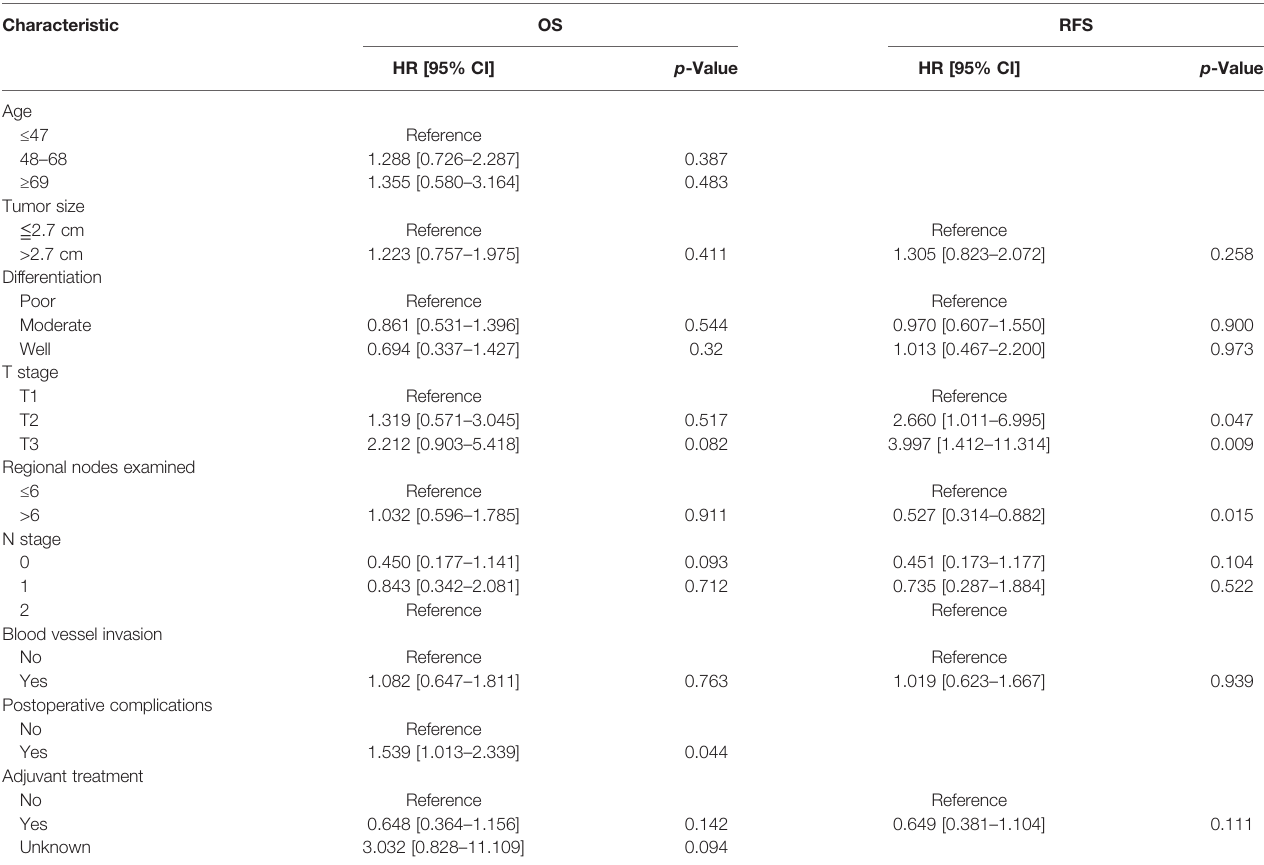
TABLE 4 | Multivariate Cox regression analyses contained N stage in the AC